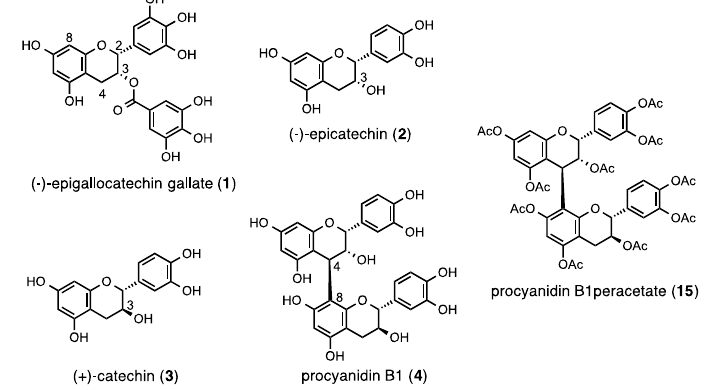
Figure 1. The structure of ( − )-epigallocatechin gallate ( 1 ), ( − )-epicatechin ( 2 ), (+)-catechin ( 3 ), procyanidin B1 ( 4 ) and procyanidin B1 peracetate ( 15